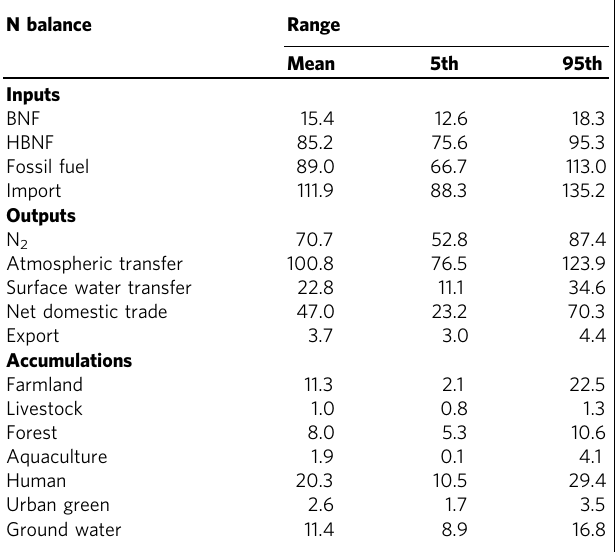
Table 1 Key N fl ows with uncertainty ranges in Guangzhou in 2015 (Gg N y − 1